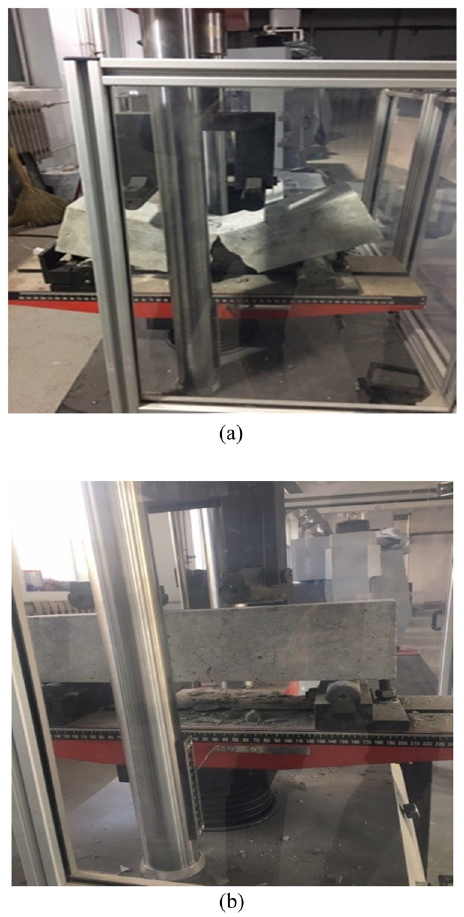
Figure 8: Flexural failure patterns of nano - concrete specimens: ( a ) specimen without SF and ( b ) specimen with 1.5% SF.